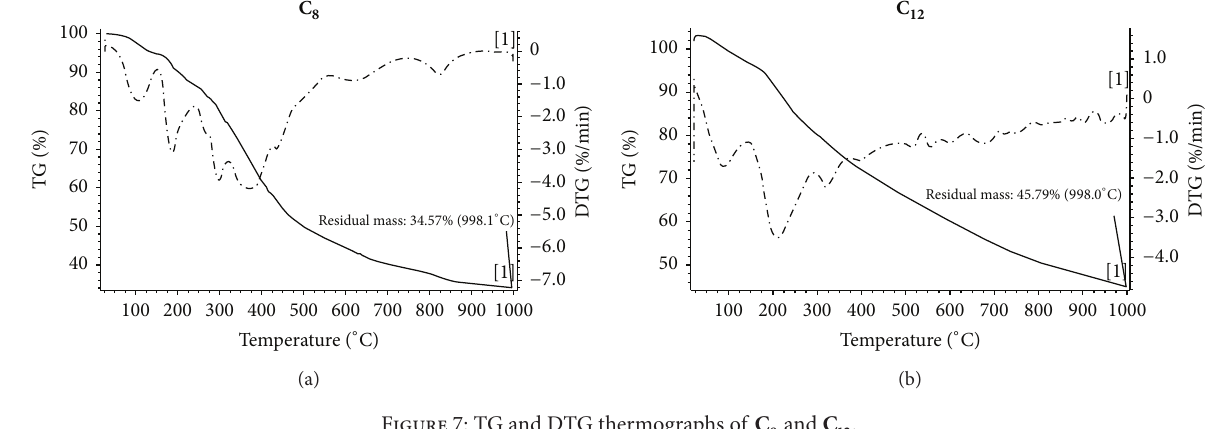
Figure 7: TG and DTG thermographs of C